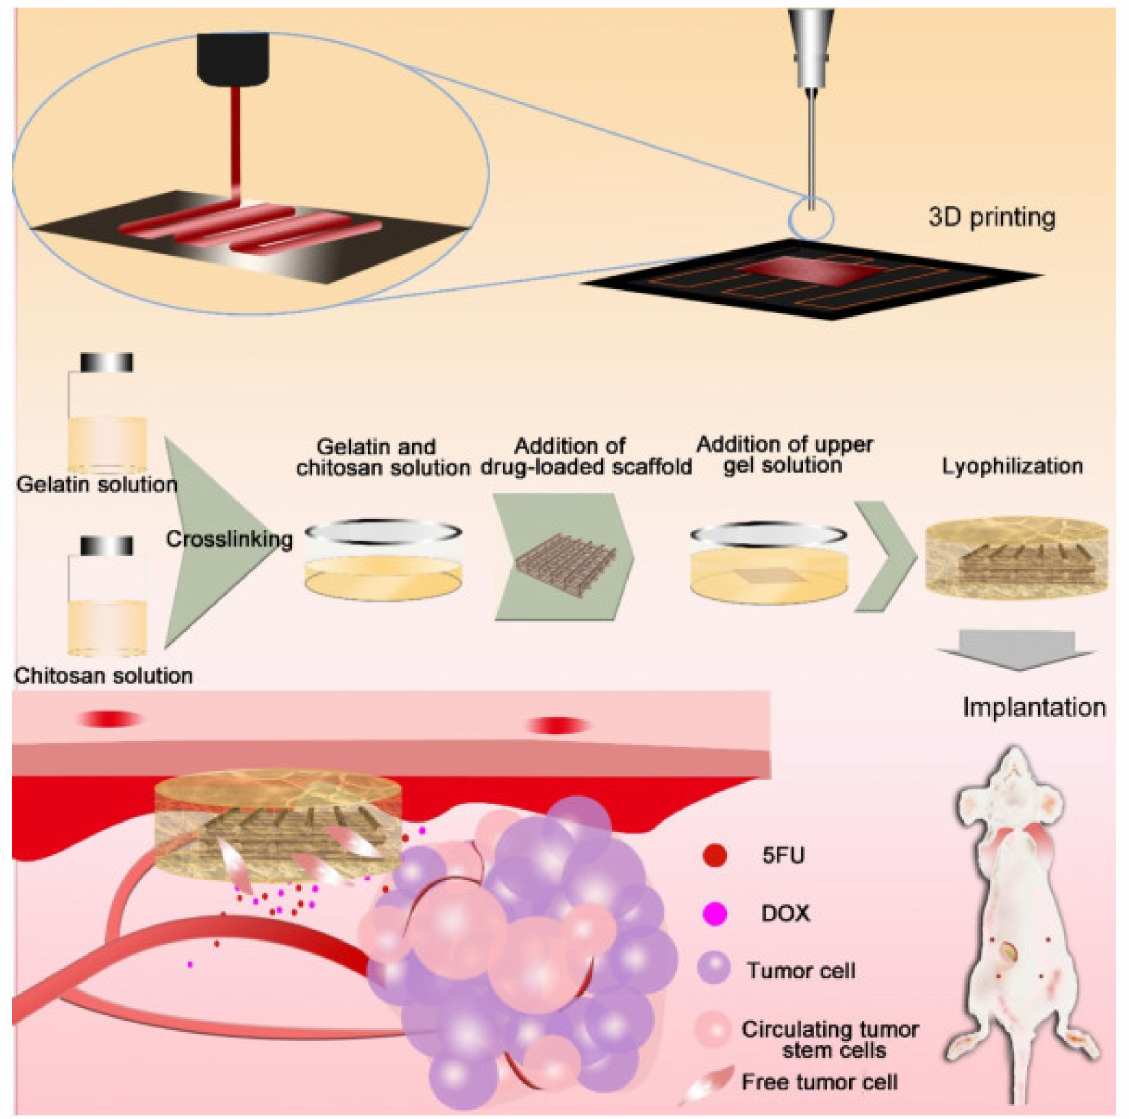
Figure 1. Fabrication of an intelligent scaffold. Hydrodynamic jet 3D printing was used to print a drug-loaded scaffolds. They were then sandwiched between a gelatin–chitosan gel. The scaffolds were implanted in vivo to absorb hemorrhage and cell residues after surgery and inhibit cancer cells and circulating tumor cells. Reprinted under the Creative Commons Attribution 4.0 International license from